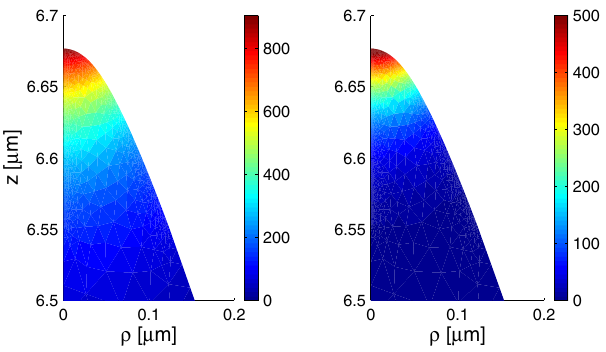
FIG. 8. Spatial distribution of the temperature rise at the time of the peak excursion in the two cases, f ¼ 1 GHz on the left and f ¼ 10 GHz on the right. (cid:5) ¼ 47 , F o ¼ 300 MV = m .